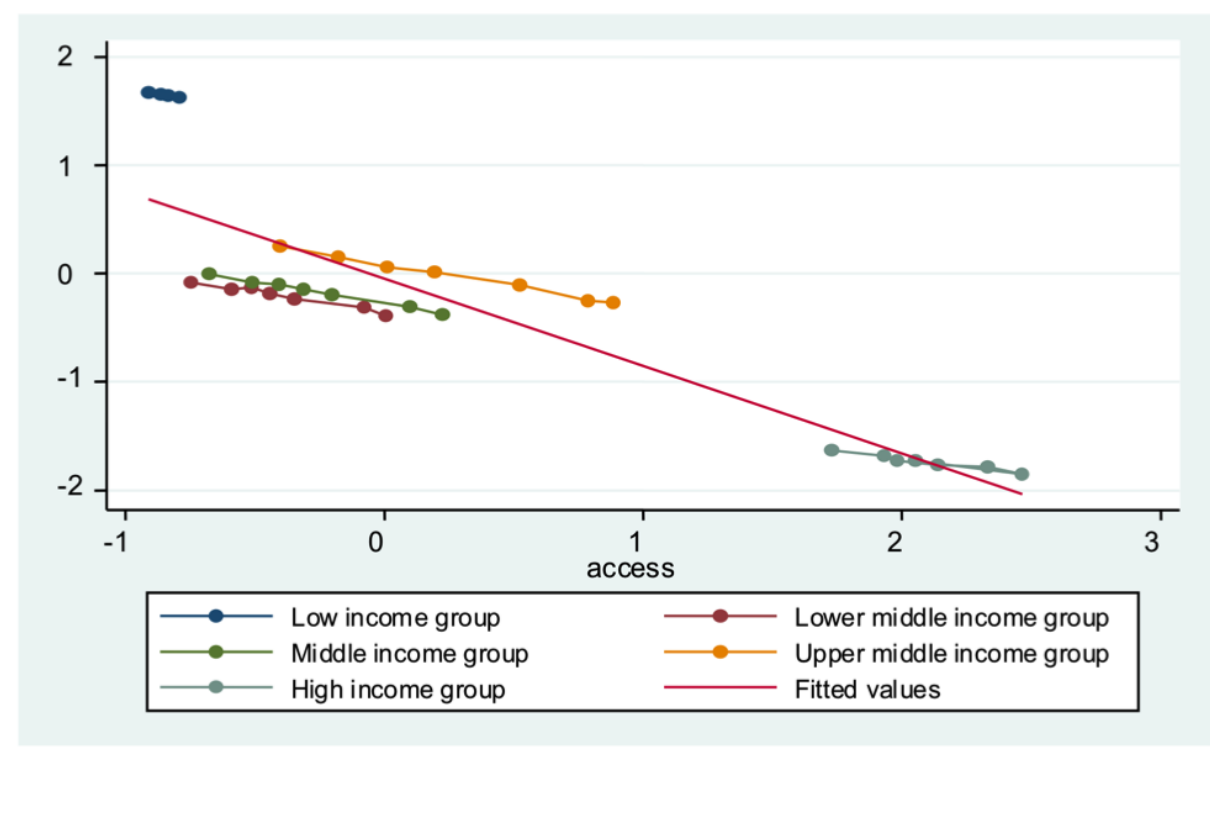
Figure 7. Impact of ICT accessibility on adult mortality